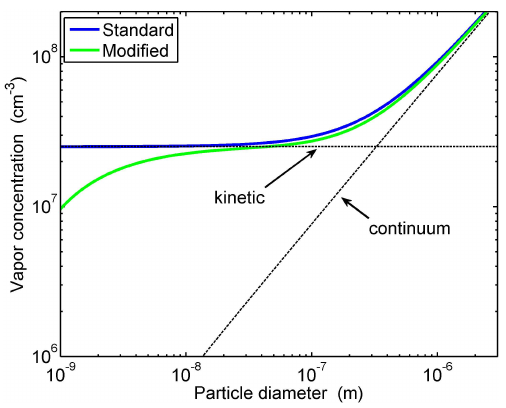
Fig. 3. Particle growth rate over 1.5–3nm diameter range as func- tion of condensing vapor molecule mass. Vapor concentration is 10 7 cm − 3 . Particle density and vapor liquid phase density are both assumed to be 1.83 g cm − 3 . “Modified” refers to the method of this study and “standard” to the Fuchs-Sutugin approach.